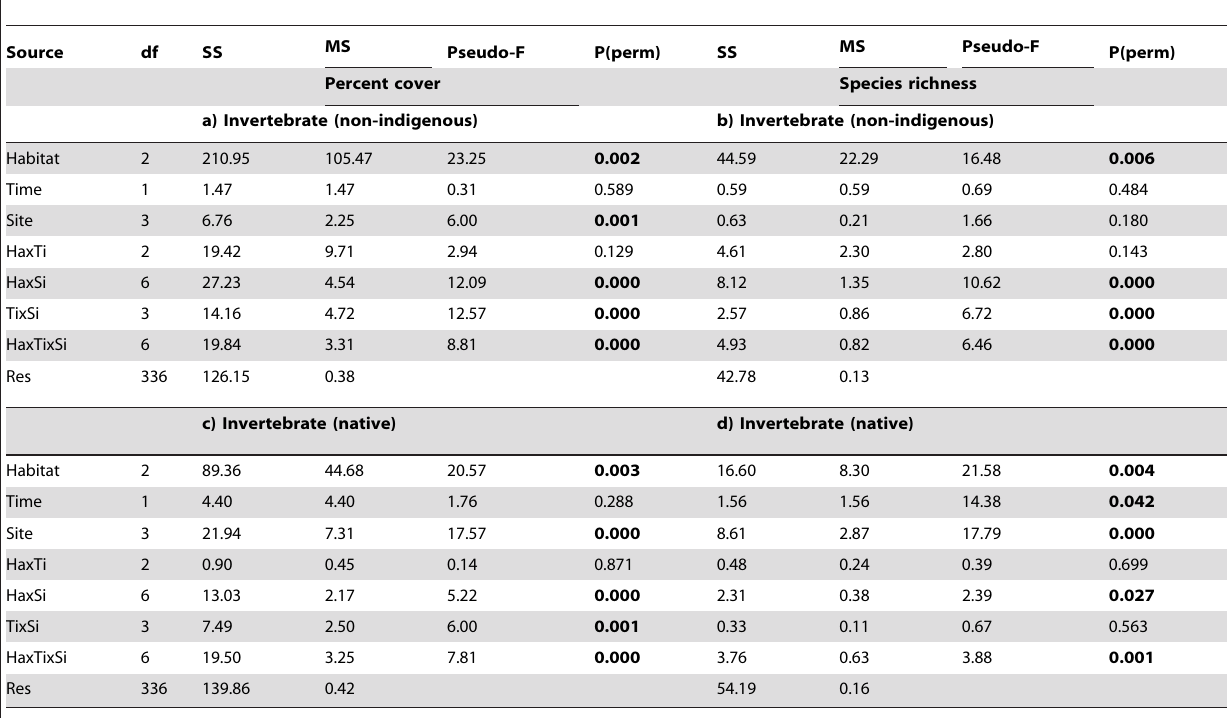
Table 1. PERMANOVA results comparing non-indigenous and native invertebrate species percent cover and richness sampled from artificial and natural